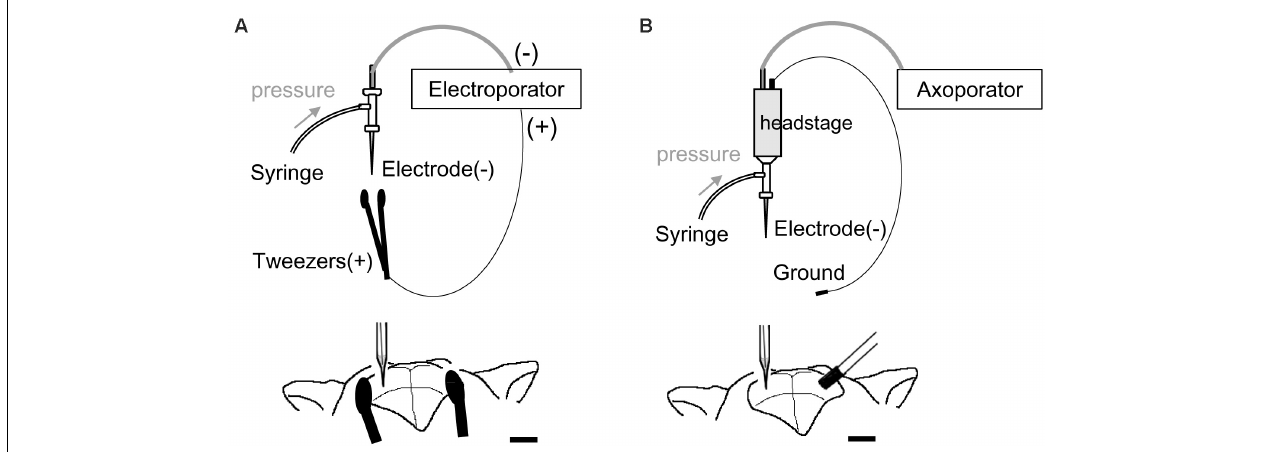
FIGURE 1 | Schematic illustration of electroporation and electrodes system. (A) Electroporation setup modified from the embryonic system. A sharp glass electrode containing the DNA solution was connected to the negative terminal of the electroporator and inserted into the target region. Tweezer-type electrode was connected into the positive terminal of the electroporator and placed outside the skull. (B) Electroporation setup modified from single-cell electroporation. A sharp glass capillary (negative electrode) was inserted into the target region and a ground electrode was placed over the contralateral hole in the skull. The glass capillary and ground electrode were connected to the